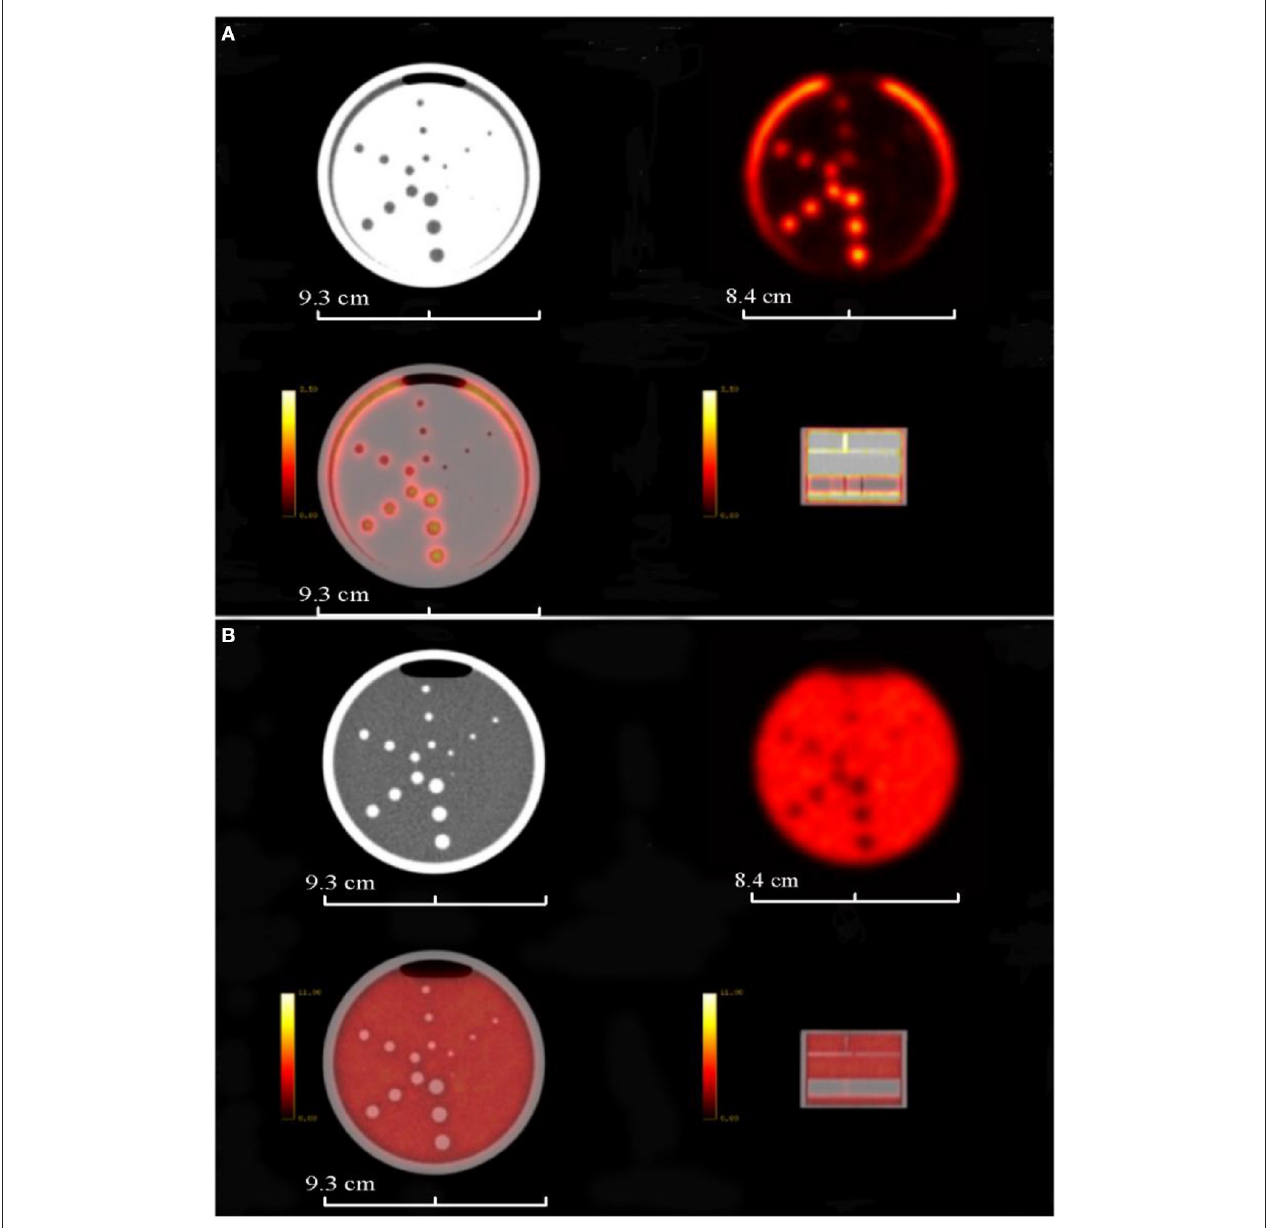
FIGURE 10 | PET/CT images of the completely 3D-printed PET/CT phantom. (A) Shows the PET/CT image layer of the high-uptake circles; (B) shows the PET/CT image layer of the dark circles. First row shows CT and PET images, and the second row shows fused PET/CT images. Phantom dimensions are marked in the figure.